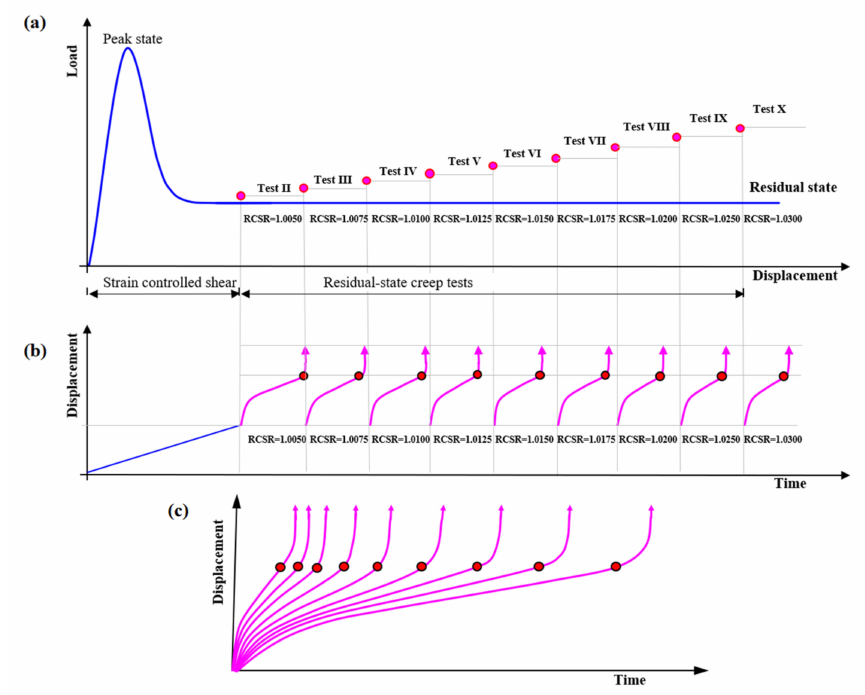
Figure 4. Overall experimental procedure for Tests II-X: ( a ) application of constant creep load for RCSR values from 1.0050 to 1.0300; ( b ) automatically recorded data from the creep tests; ( c ) analysis results for the interpretation of different creep stages.